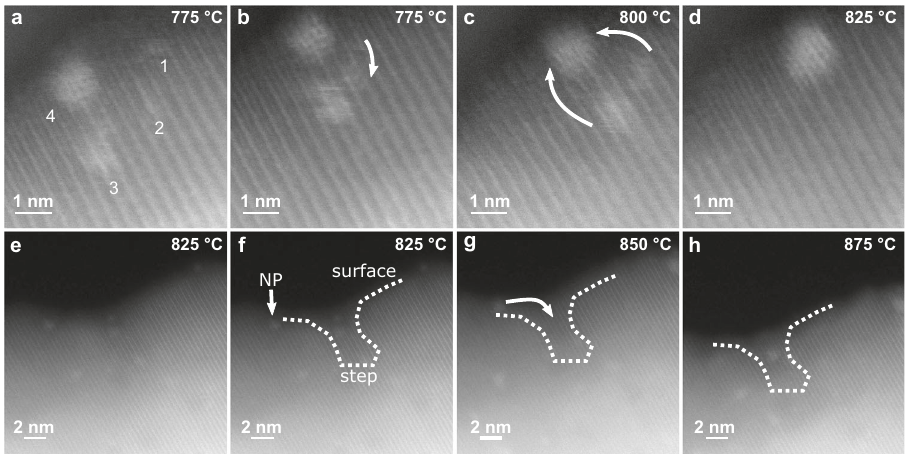
Fig. 3 | Movement of Ir atomic clusters on the surface of the host. a – d STEM micrographs of the surface of a SrIr 0.005 Ti 0.995 O 3 grain monitored in situ at 775 – 825°C. Ir atomic clusters (1 – 4) are labelled, with clusters 1 and 2 fi rst coales- cing, before further combining with clusters 3 and 4. e – h STEM micrographs of a stepped surface of a SrIr 0.005 Ti 0.995 O 3 grain monitored in situ at 825 – 875°C. The